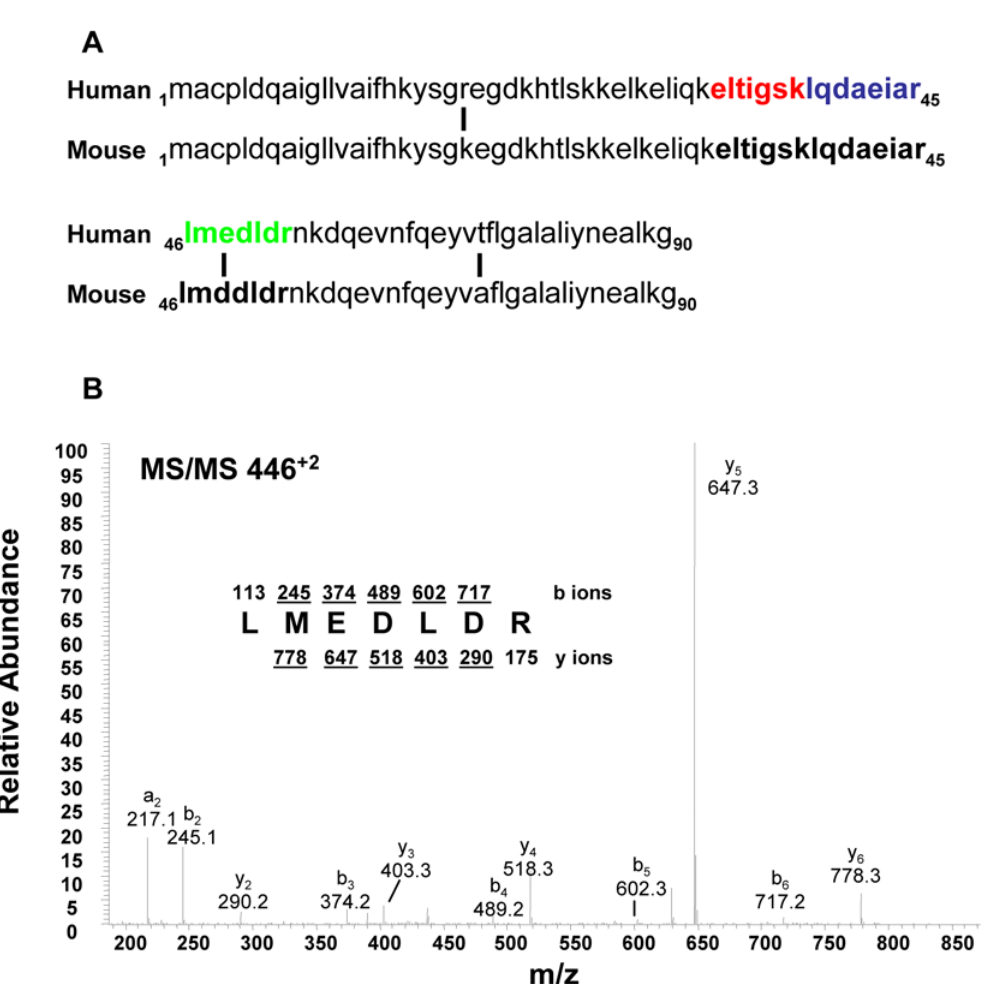
Figure 3. S100A6 protein sequence. (A) Aligned human and mouse S100A6 sequences depicting 3 amino acid differences between the two species (vertical lines). Three peptides were detected by LC-LTQ MS/MS from tumor-bearing mouse sera; sequences are shown in color font. Peptides in red and blue font are homologous for human and mouse, while the peptide sequence in green font is unique to human S100A6, due to one amino acid difference. (B) MS/MS spectrum of the human-specific S100A6 peptide, LMEDLDR. This sequence was not detected in saline-inoculated control mice sera.